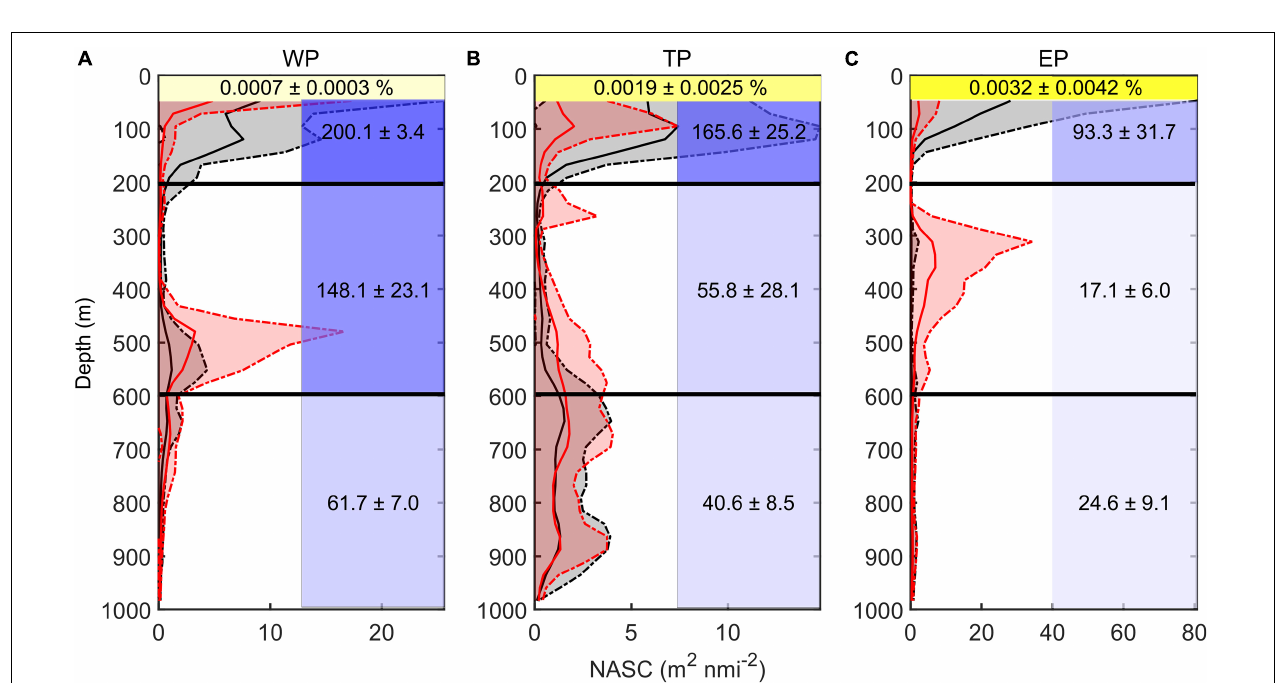
FIGURE 5 | Vertical distribution of backscatter and environmental features. (A) Western part; (B) transition part; and (C) eastern part. Red lines showed the average midday-time profiles (10:00–14:00), red shadows were the range of standard deviations. Black lines showed the average midnight-time profiles (22:00–next day 2:00), gray shadows were the range of standard deviations. Yellow shadows represent the remaining light intensity (%) down to the WMD. Blue shadow in each grid represented the average oxygen concentration ( µ mol kg - 1 ; upper, 50–200 m; middle, 200–600 m; lower, 600–1000 m). The value (means ± SD) of environmental variable in each grid was also